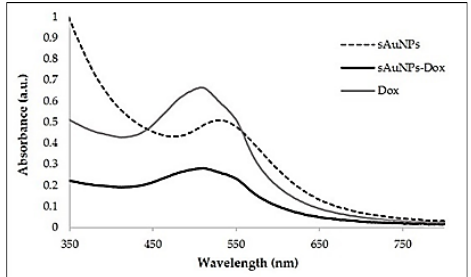
Figure 5. UV/Visible absorption spectra of doxorubicin alone, the sAuNPs and the sAuNP-doxoru- bicin (sAuNPs-Dox) conjugate in water.